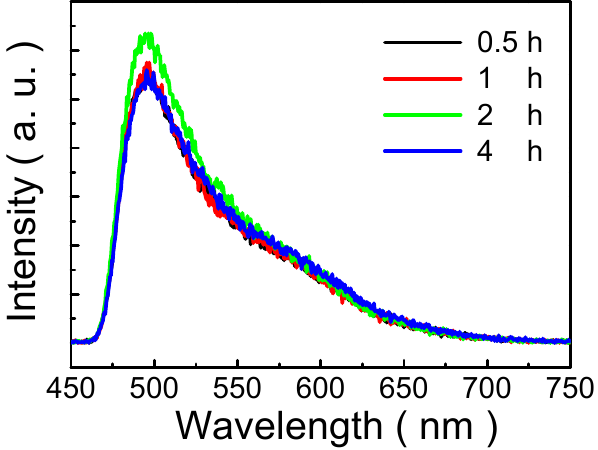
Figure 7. PL spectra of MP1D films annealed for various periods (0.5, 1, 2, and 4 h).